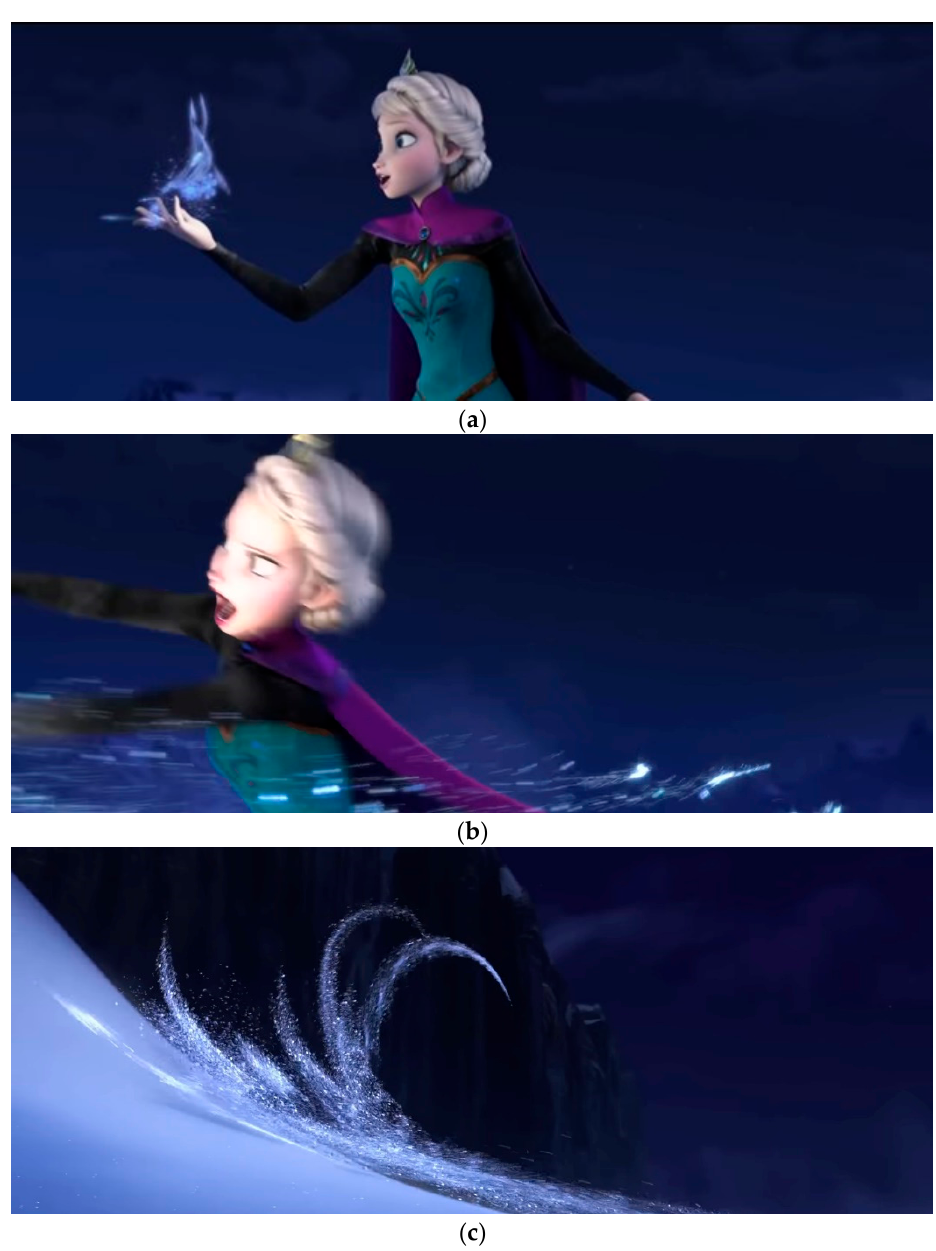
Figure 3. ( a ) Elsa with snow magic. ( b ) Elsa controlling snow magic. ( c ) The snow magic Elsa has made (Walt Disney Animation Studios